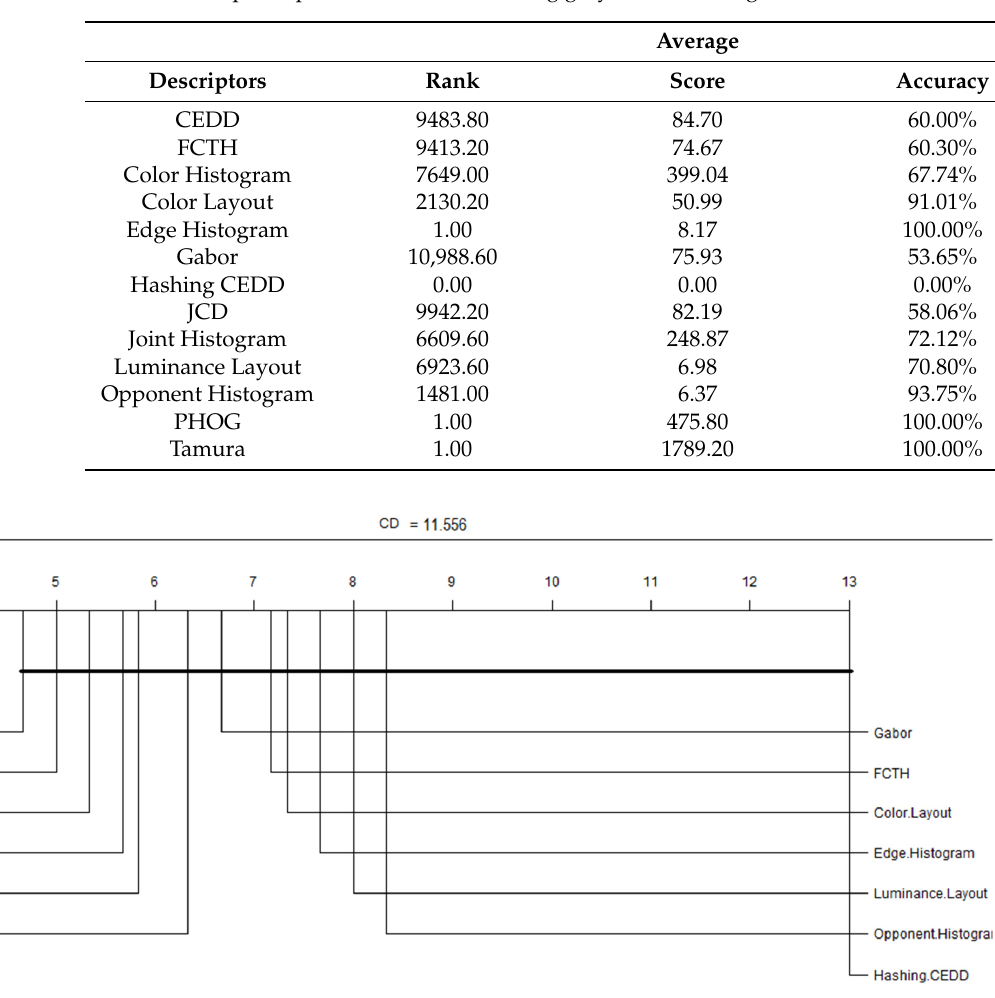
Table 6. Descriptors’ performance for retrieving grayscale face images.